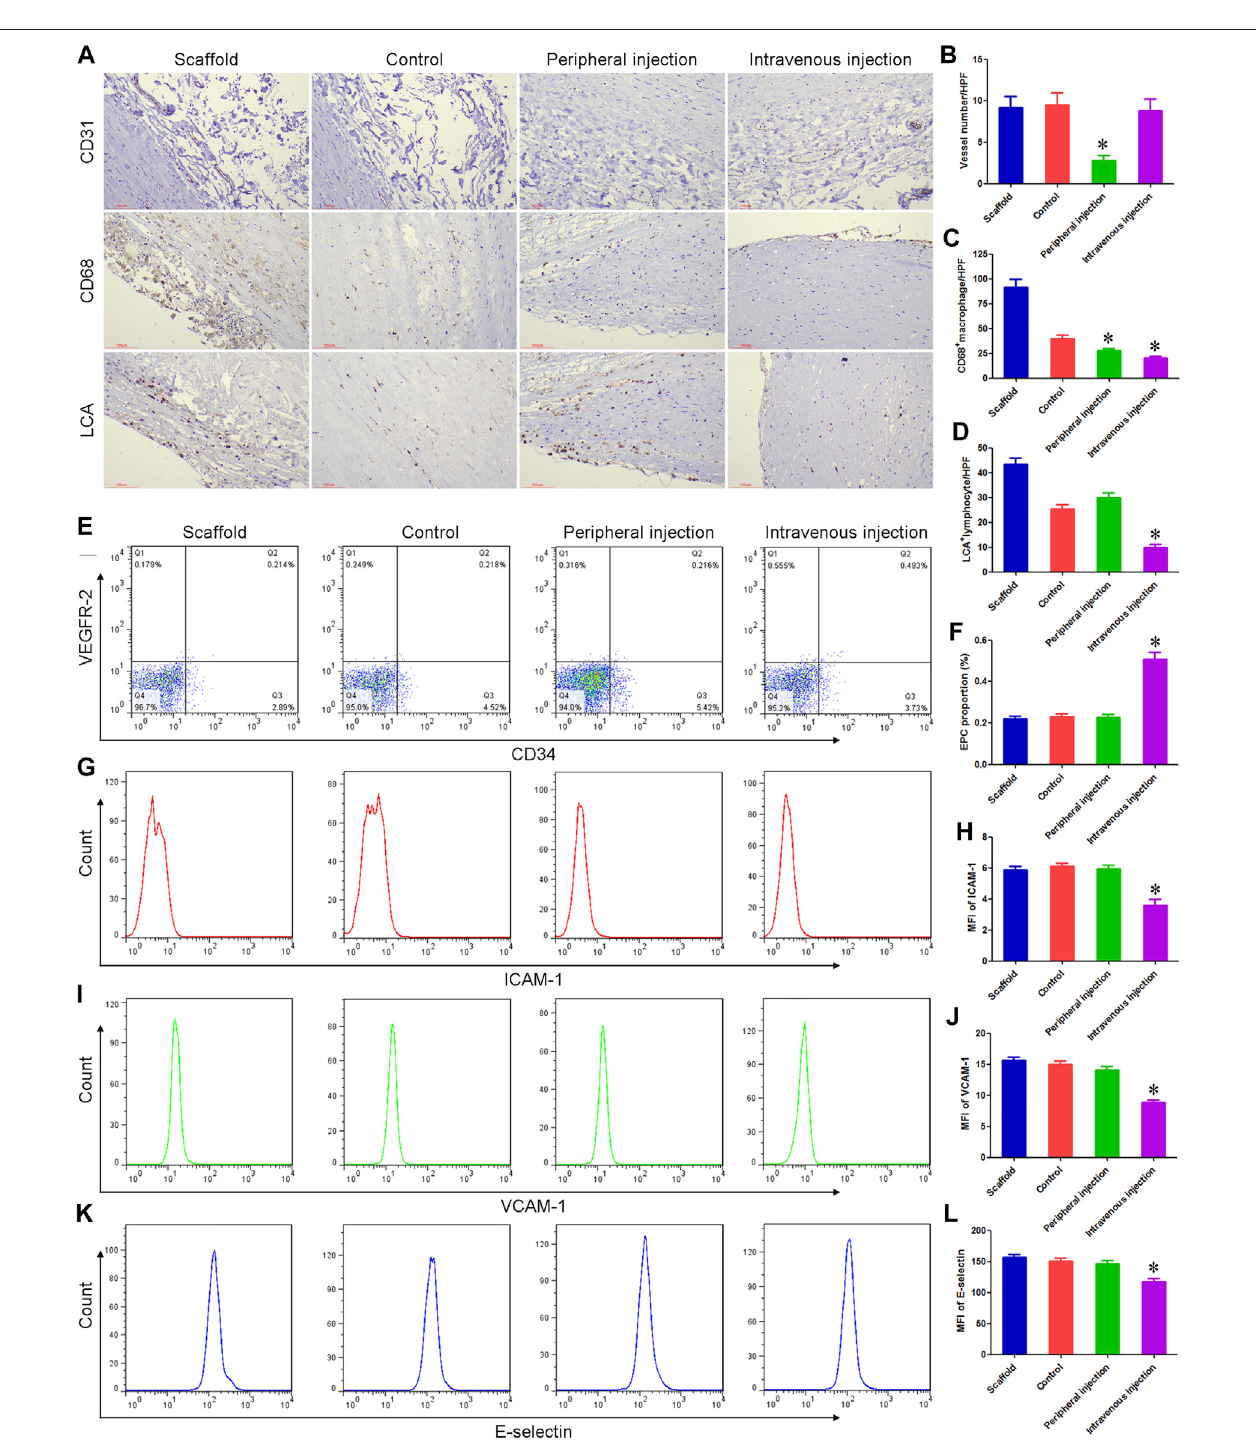
FIGURE 3 | Treg cell transplantation reduced the in fl ammatory response associated with TEBV implantation in diabetes mellitus. (A) Immunohistochemistry was used to detect the expression of CD31, CD68, and lymphocyte common antigen (LCA). (B – D) Compared with the control group, the number of macrophages (CD68 + ) andmicrovesseldensity(CD31 + )aroundTEBVdecreasedintheperipheralinjectiongroup,respectively,whilethenumberoflymphocytes(LCA + )didnotdifferstatistically betweenthetwogroups.Comparedwiththecontrolgroup,therewasnosigni fi cantchangeinCD31 + microvesseldensityaroundTEBVintheintravenousinjection group,whilethenumberoflymphocytesandmacrophageswassigni fi cantlyreduced. (E) FlowcytometrywasusedtodetecttheproportionofEPCsinperipheralblood. (F) Compared with the control group and peripheral injection group, the proportion of EPCs was signi fi cantly increased in the intravenous injection group. (G,I,K) Flow cytometry wasusedtodetect theexpression ofICAM-1, VCAM-1, and e-selectinonEPCs. (H,J,L) Comparedwiththecontrolgroupand peripheralinjection group, the expression of ICAM-1, VCAM-1, and e-selectin was signi fi cantly decreased in the intravenous injection group. * p < 0.05 ( n = 8) versus Control group. Values are mean ±